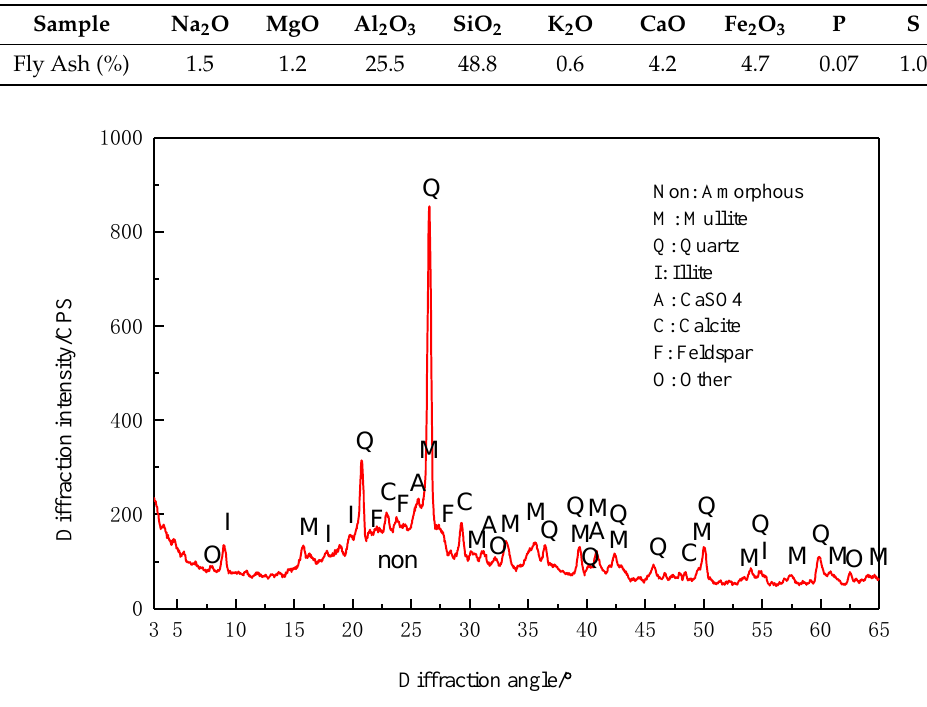
Table 2. Chemical composition of fly ash.